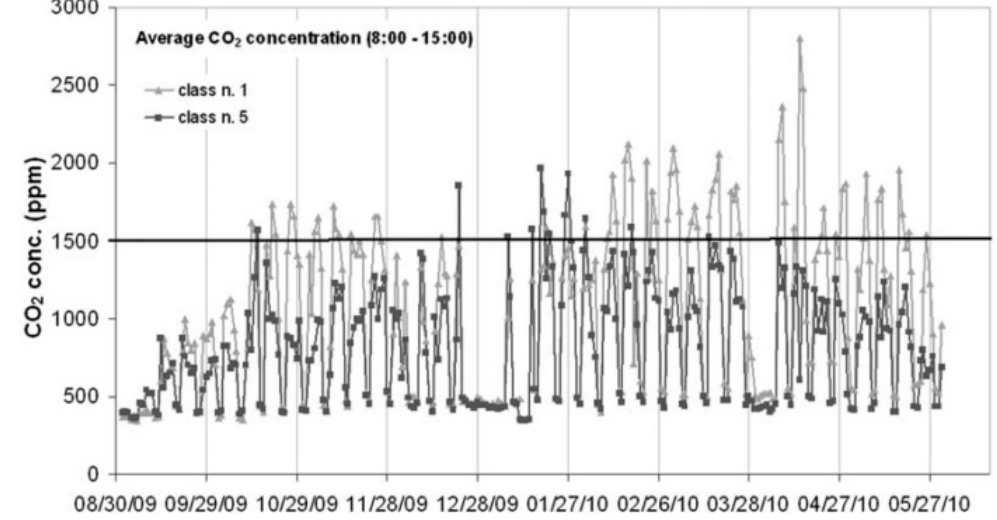
Figure 26. Average CO 2 concentration throughout the 2009–2010 scholastic year [12].